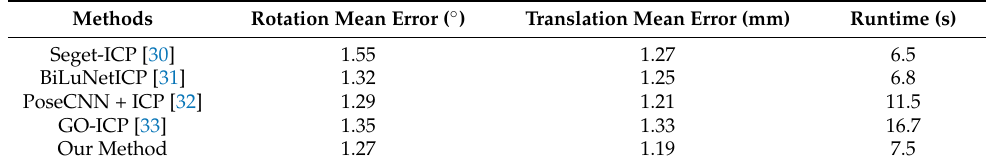
Table 2. 6D Pose Estimation Results.